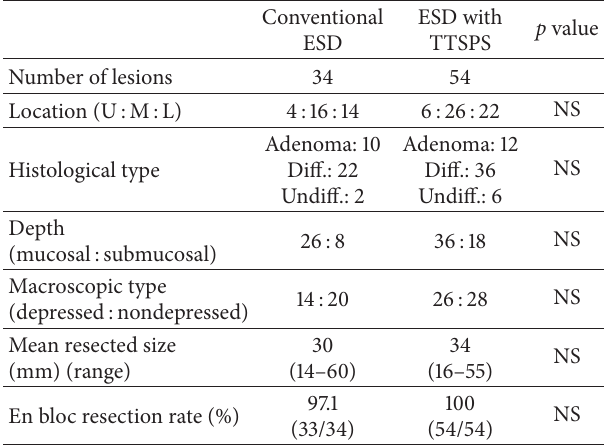
Table 2: Characteristics of the tumors. Table 3: Comparisons between conventional ESD and ESD with